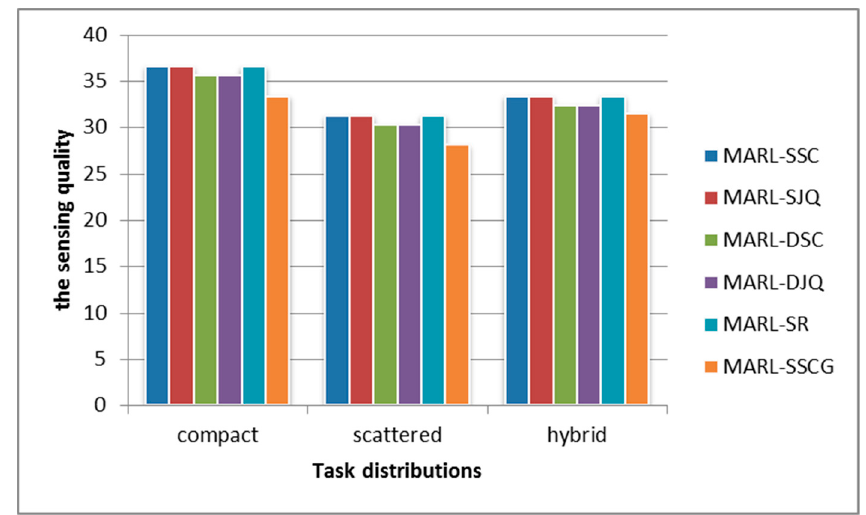
ff erent mobile sensing tasks Figure 5. The sensing quality under different mobile sensing tasks distributions. Figure 5. The sensing quality under di